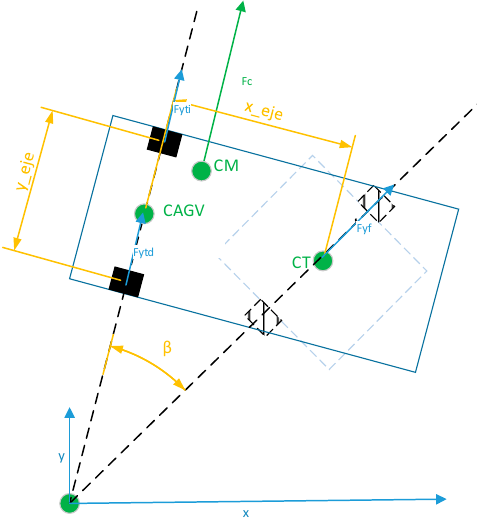
Figure 17. Model of the lateral loads on the wheels.